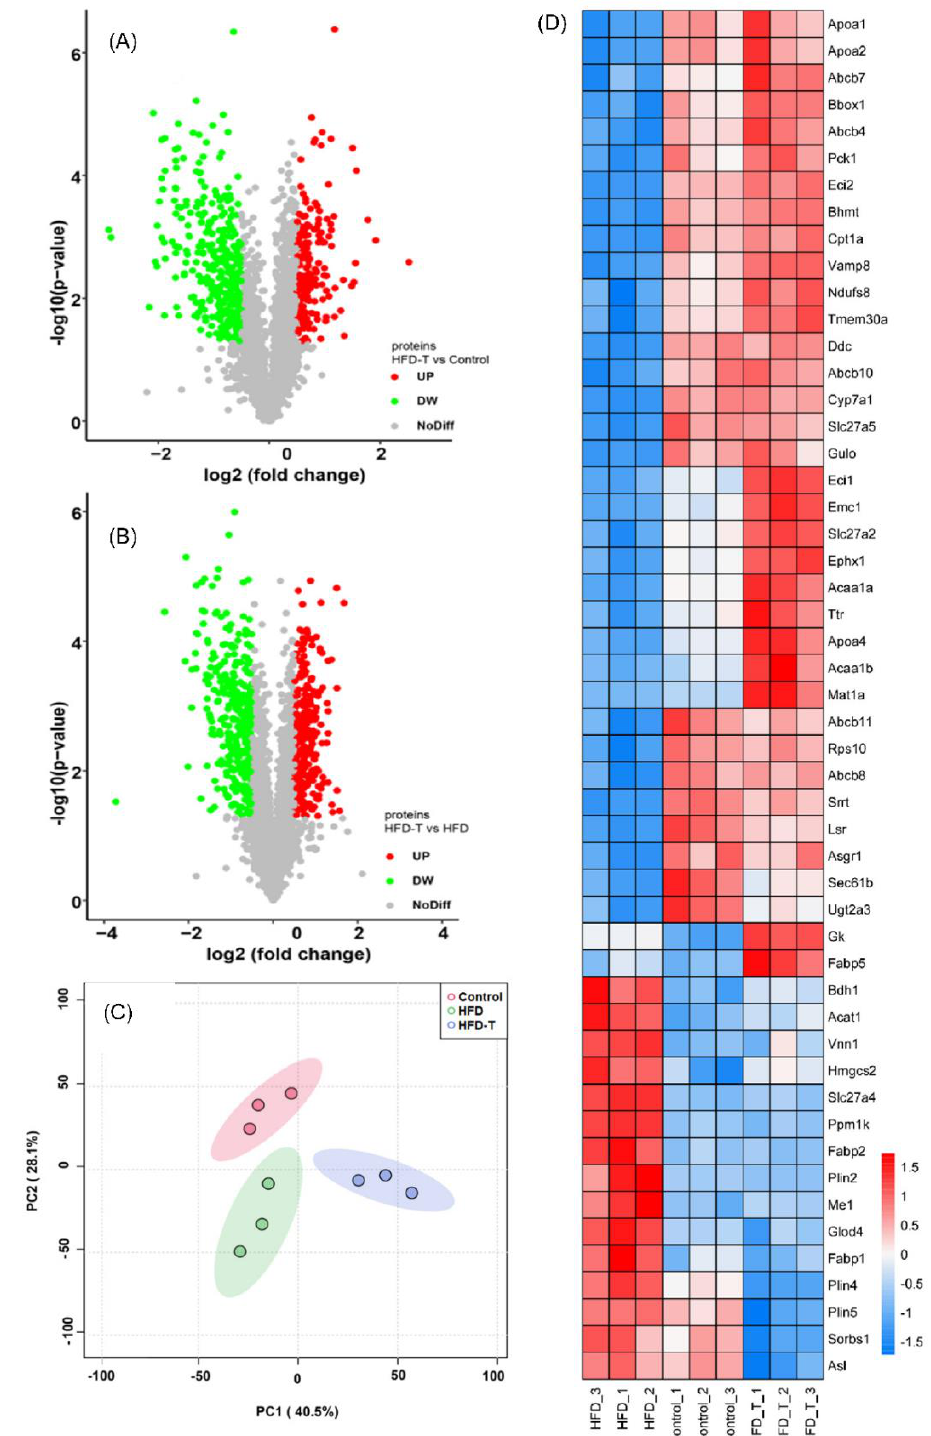
Figure 3. The volcano plot of DEPs ( A , B ) and the PCA analysis ( C ) under different treatment or diet as well as the heatmap of DEPs ( D ).